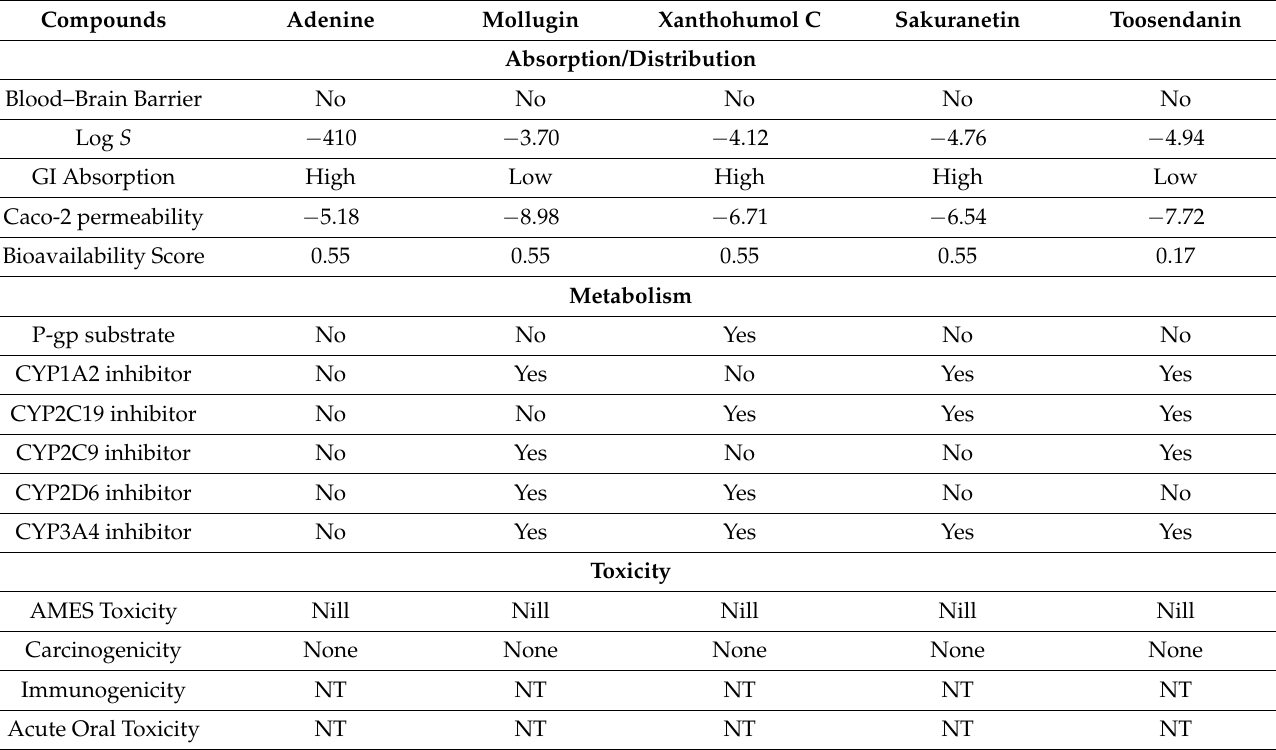
Table 6. ADMET properties of the finest docked